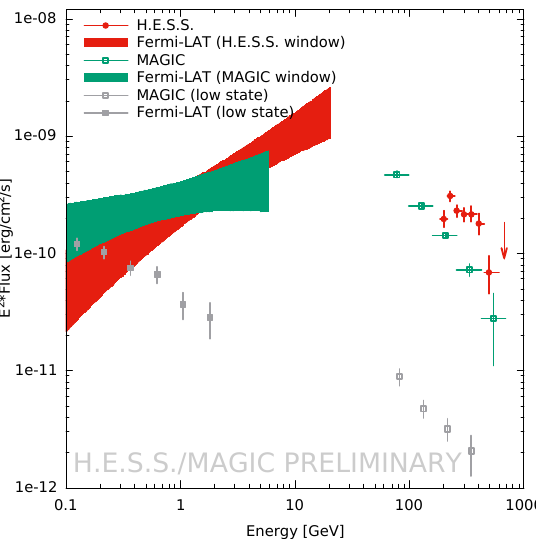
Figure 7. γ -ray spectral energy distribution for the H.E.S.S. (red) and MAGIC (green) observation windows of the maximum night. The Fermi -LAT confidence regions have been derived for strictly simultaneous time windows with the IACT observations. The gray spectra are the low-state data sets of MAGIC and Fermi -LAT [16]. The spectra have been corrected for EBL absorption using